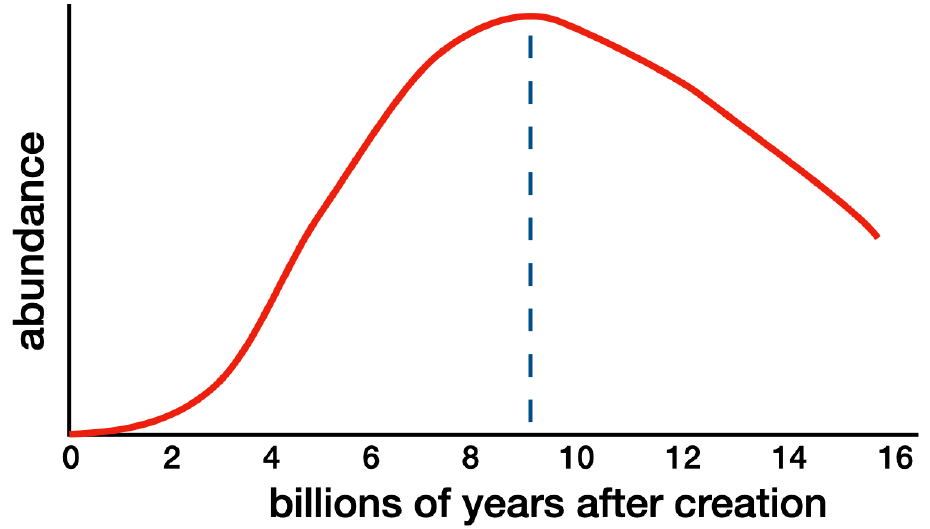
Figure 1. Abundance of Uranium and Thorium Throughout Cosmic History. Uranium and thorium are exclusively manufactured during supernova eruption events and merger events of neutron stars. As the universe expands and stars disperse, these events become progressively less frequent. Meanwhile, thorium-232, uranium-235, and uranium-238 decay with half-lives of 14.05, 0.704, and 4.468 billion years, respectively. Consequently, the concentration of uranium and thorium builds up during the first several billion years of cosmic history when star formation rates are high. Later, when star formation rates decline, the radioactive decay of uranium and thorium supersedes the production of uranium and thorium from supernova eruptions and mergers of neutron stars. One reason why Earth has such an enormous concentration of uranium and thorium is that it formed when the cosmic abundance of uranium and thorium had peaked (Yungelson and Livio 2000; Kobayashi and Nomoto 2009; Spina et al. 2016; Tsujimoto 2023). Diagram credit: Hugh Ross.